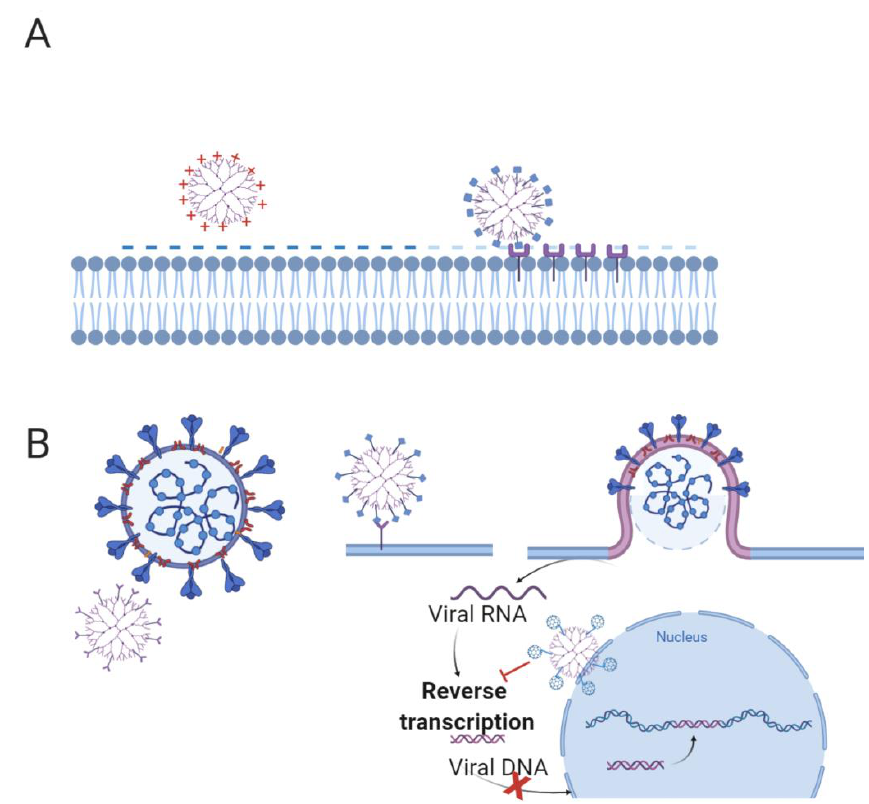
Figure 5. ( A ) Cationic dendrimers and maltose-conjugated dendrimers, the antimicrobial activity of which is related to the electrostatic interaction and consequent permeabilization of the bacterial membranes, or the interaction with specific receptors on the host-cell membrane. ( B ) Antiviral anionic dendrimers acting on different steps of viral infection. Created with